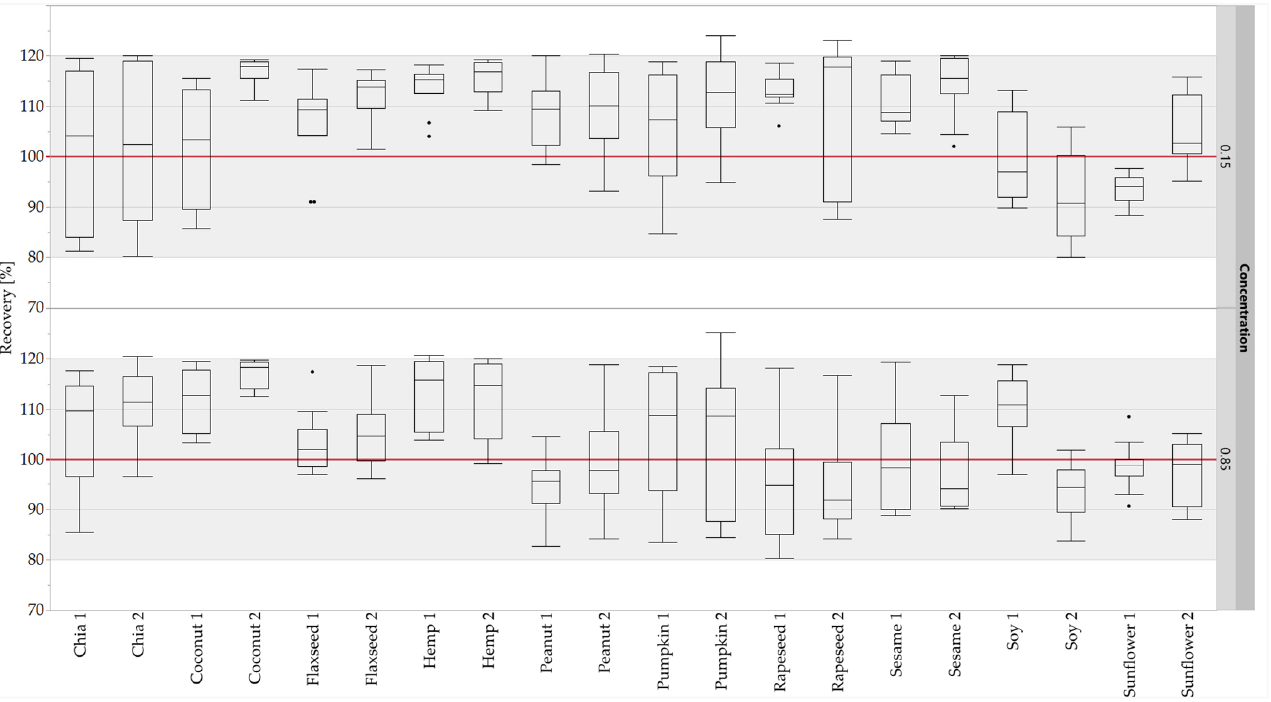
Figure 6. Recovery rates of the oilseed peptides in emulsion-type sausages (0.15 and 0.85% protein) quantified with standard sausages (0.01–1.0% oilseed protein content). Both concentration levels (0.15 and 0.85%) were measured in duplicate from two different sausage samples and three indepen- dent sample preparations: box plots are from twelve measurements. The gray areas represent the accepted range of